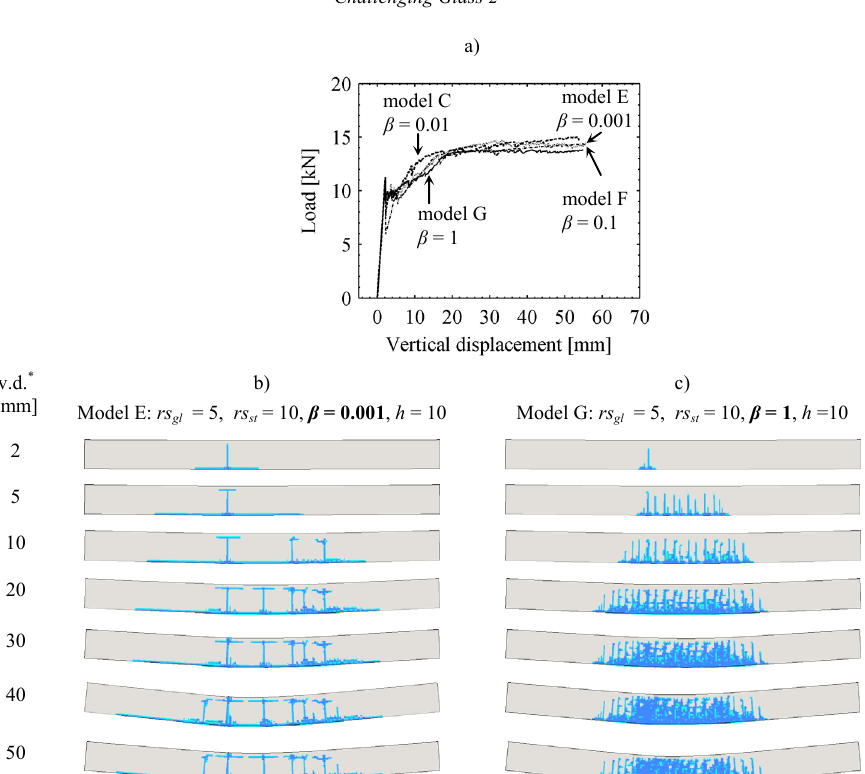
Figure 8: a) Load-displacement diagrams of models C, E, F and G with varying shear retention factors; b) contour plot of the reduced E-moduli (crack pattern) of model E; c) contour plot of the reduced E-moduli (crack pattern) of model G; * v.d. = vertical